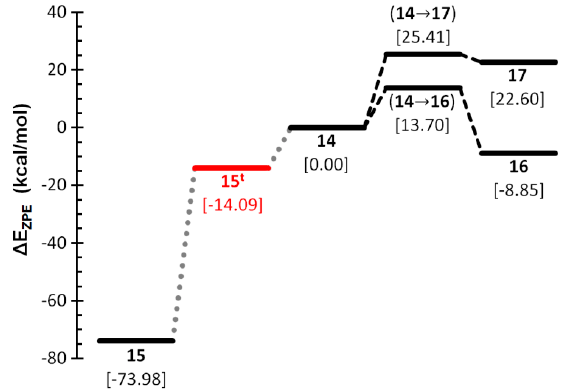
Figure 6. Computed (CCSD(T)/def2-TZVPP//B3LYP-D3/def2-TZVP) zero-point corrected energy profile for the interconversion of COP − isomers.